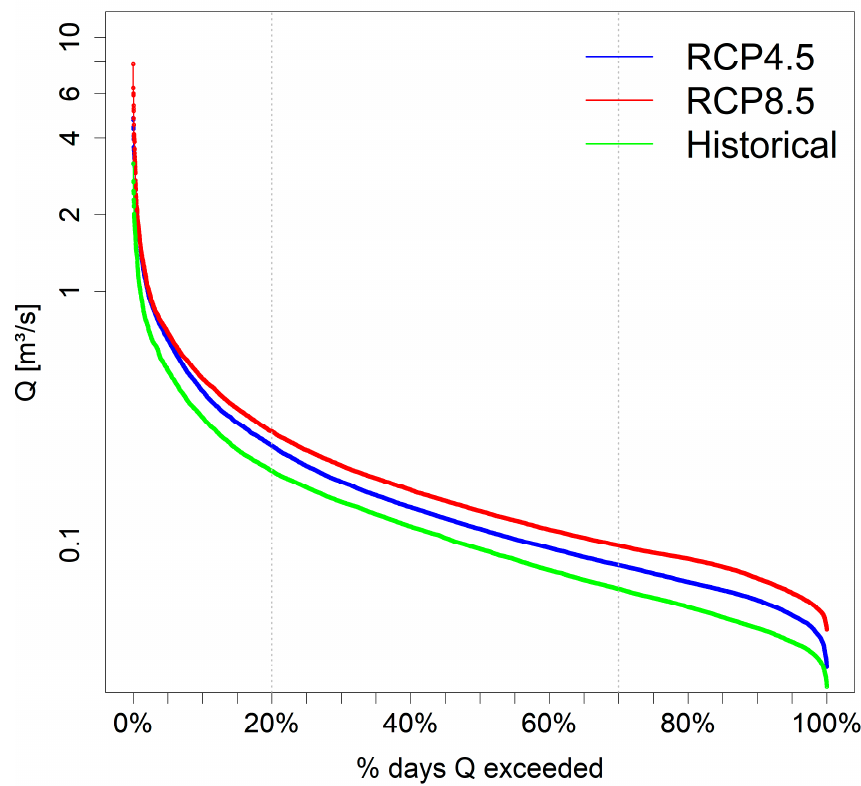
Figure 8. Impact of climate change on the exceedance probability of daily discharge in the inland valley. The y-axis is plotted on a log scale. Daily discharge is simulated using bias-corrected daily precipitation from historical (1976–2005) and future (2021–2050) periods.